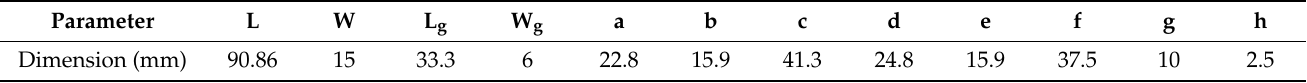
Figure 2. Prototype of realized monopole antenna array. ( a ) Front view and ( b ) back view.